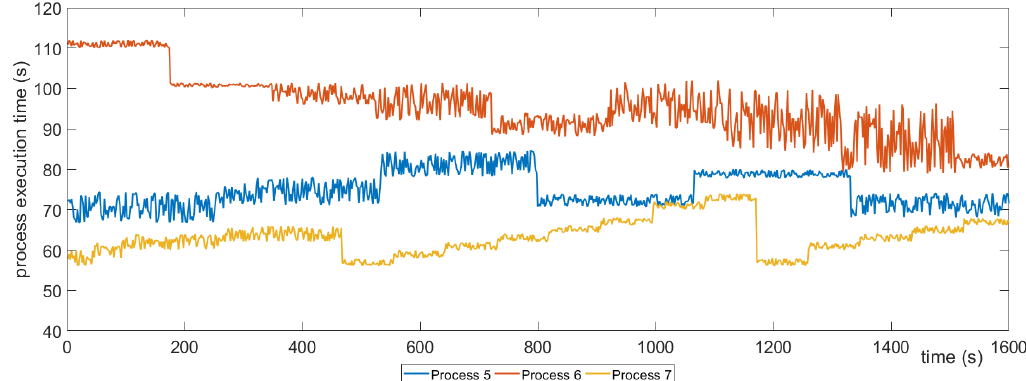
Figure 27. Medium priority processes.